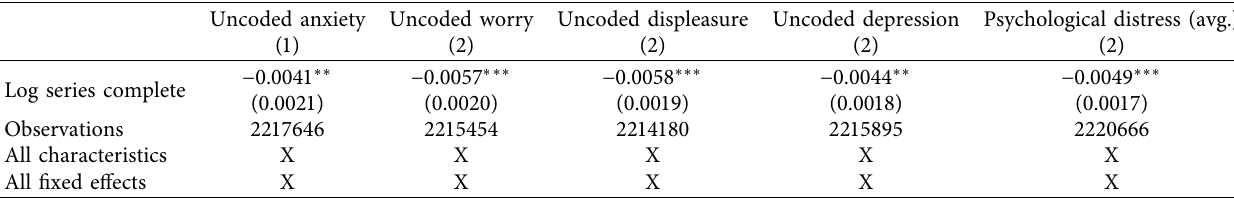
Table 8: Vaccination and mental health—other outcome measures.